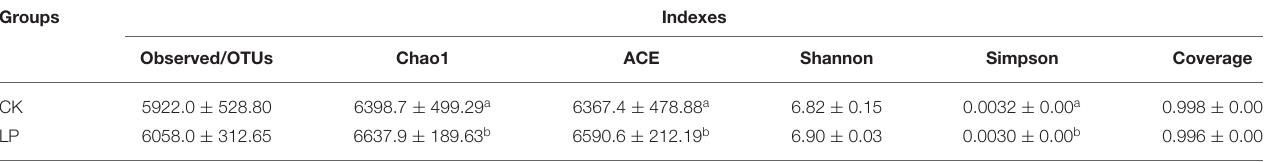
TABLE 3 | Richness and diversity indices of different treatment groups. Groups